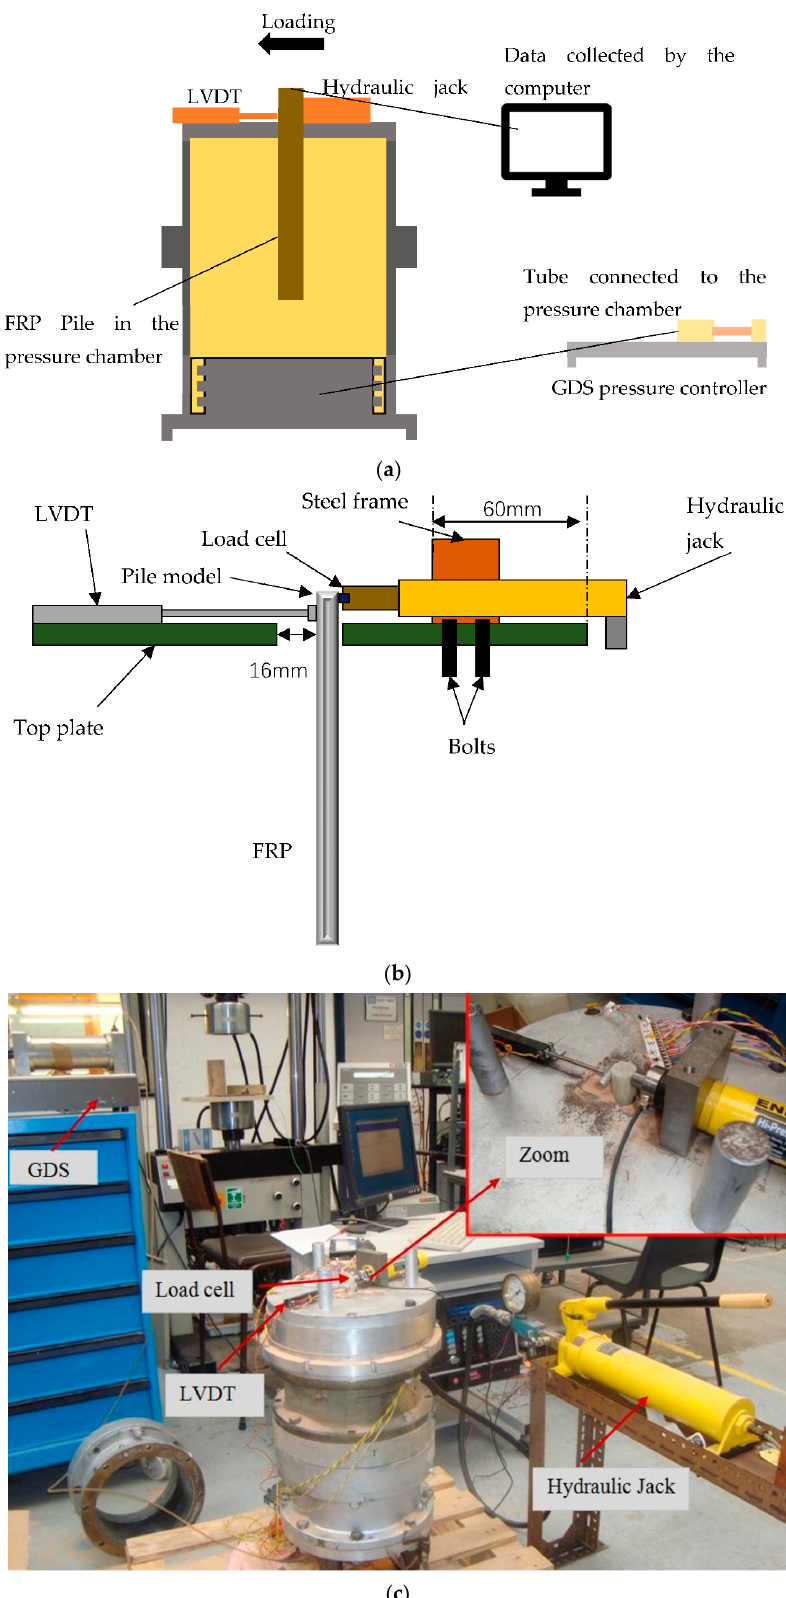
Figure 4. Profile of the pressure chamber tested the under lateral load ( a ), enlarged drawing of lateral loading setup ( b ), and actual profile of the test condition ( c ).